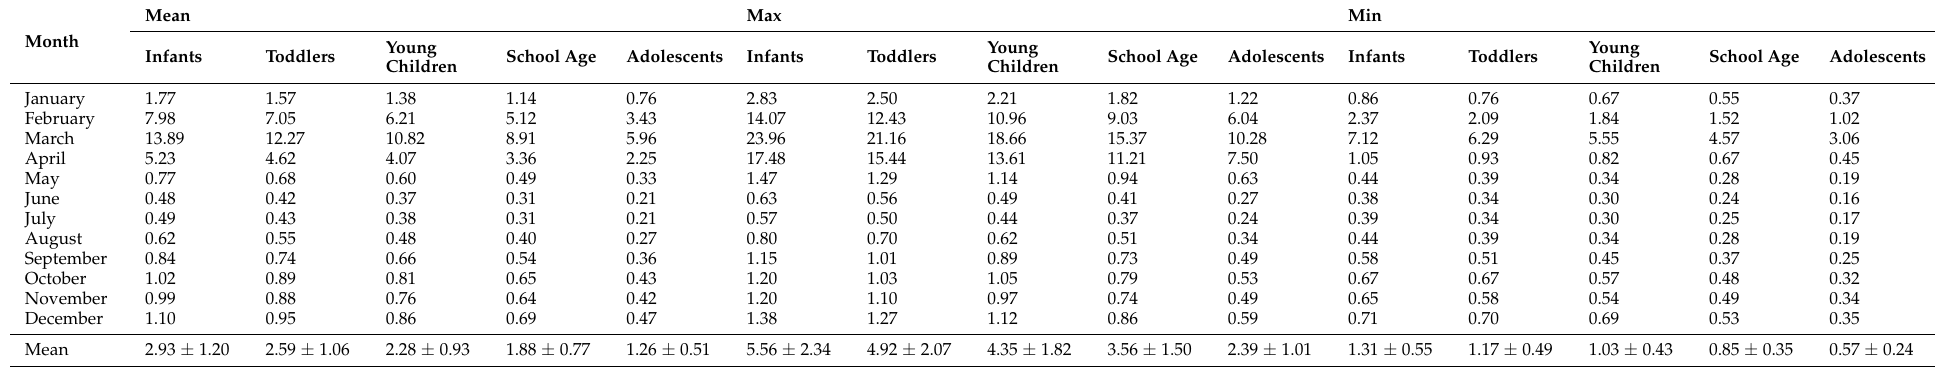
Table 3. Mean, maximum, and minimum of the monthly means of the HQ related to PM 2.5 according to the age-related development period in children during